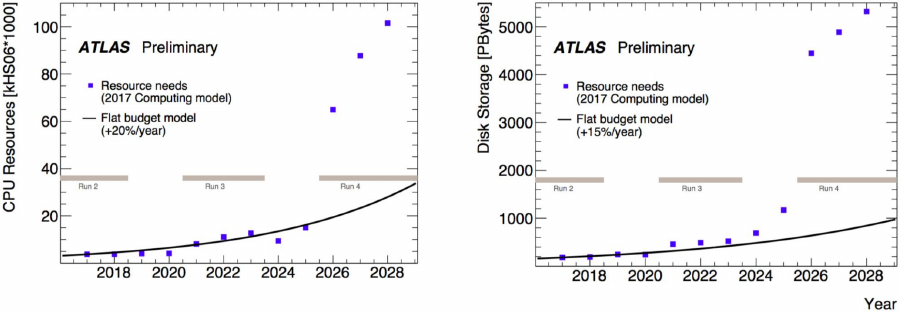
Figure 2. Predicted Compute and Storage Needs against Flat Budget Model for ATLAS